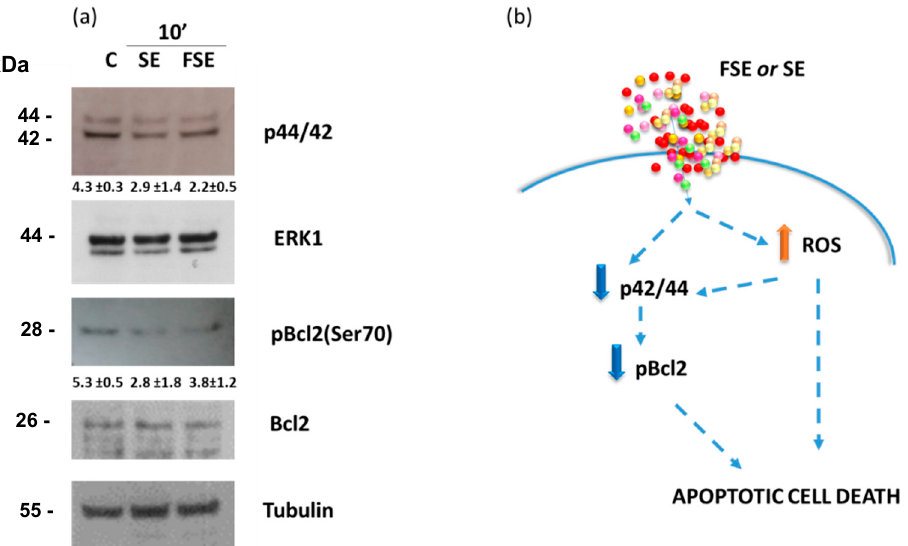
Figure 7. FSE modulation of ERK/MAPK pathway and phosphoBcl-2(Ser70). ( a ) Immunoblot analysis of p44/42-ERK1 and phosphoBcl2(Ser70)-Bcl2 expression in HL-60 cells treated with 25 µ M eqGA of FSE or SE for 10 min. Densitometric analysis (numbers between panels ± SD) was obtained by normalizing the expression of p44/42 with ERK1 and tubulin, and the expression of pBcl2(Ser70) with Bcl2 and tubulin. ( b ) Schematic representation of the possible mechanism of the action exerted by FSE.